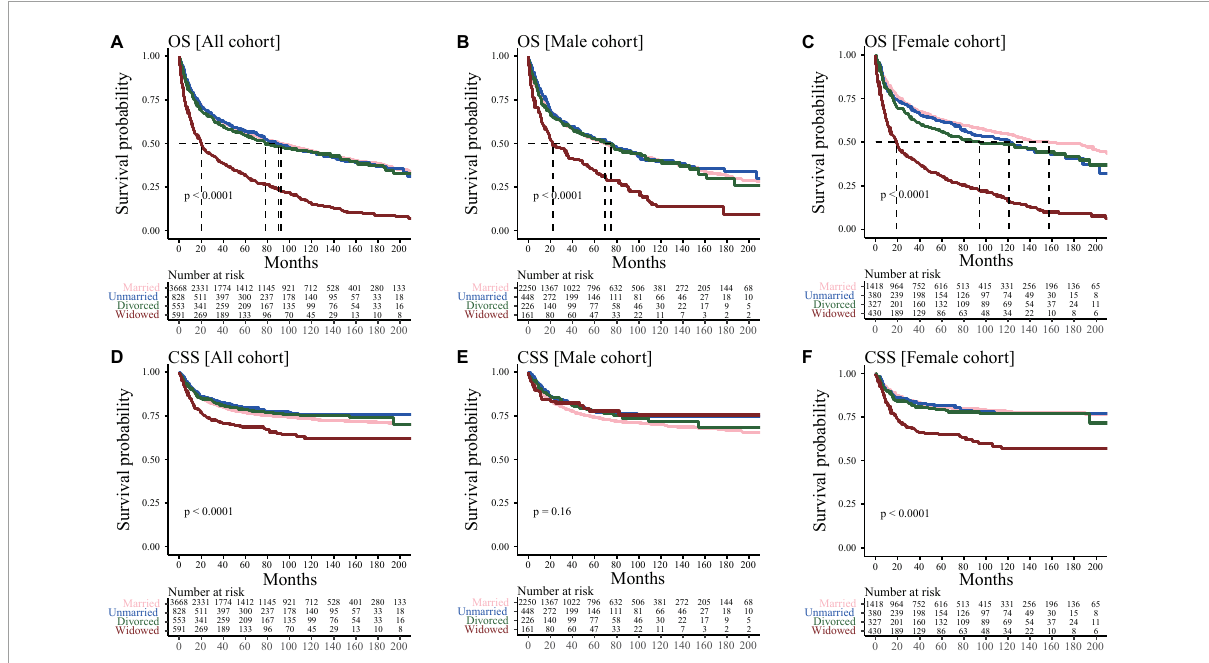
FIGURE1 Kaplan–Meier curve for analyzing the effects of marital status on survival. (A) Overall survival (OS) in all cohorts; (B) OS in the male cohort; (C) OS in the female cohort; (D) Cancer-special survival (CSS) in all cohorts (E) CSS in the male cohort; (F) CSS in the female cohort.